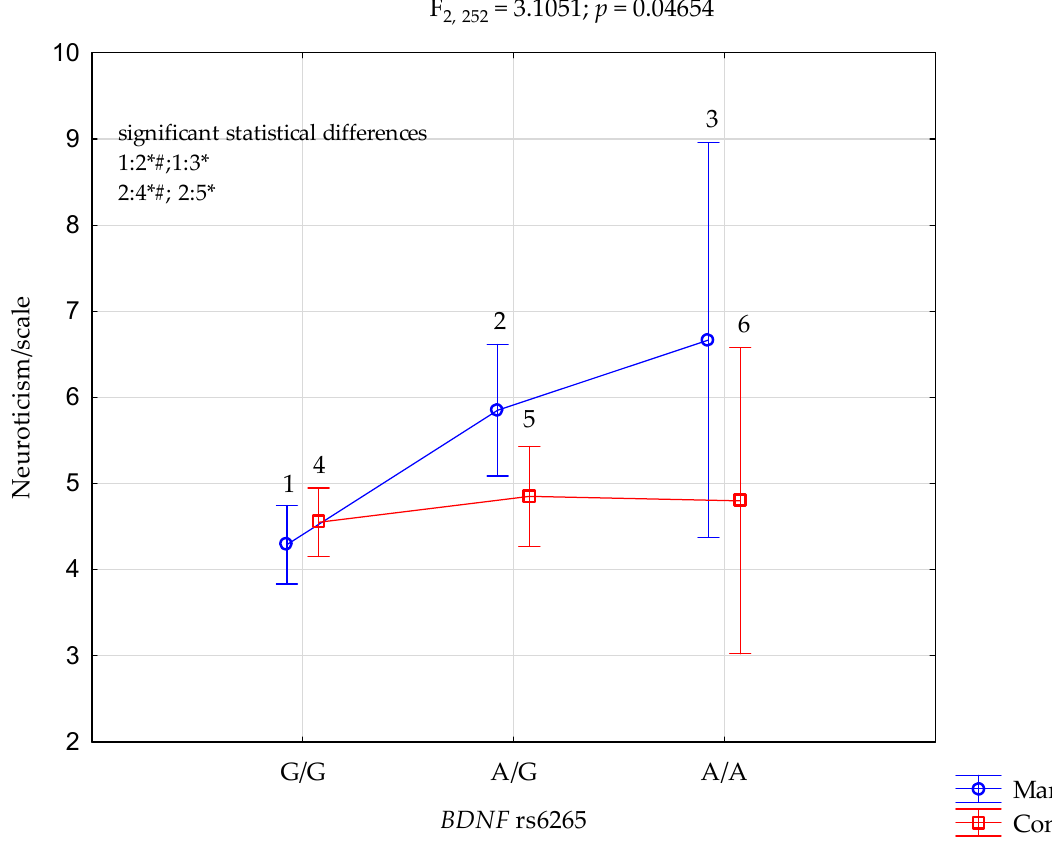
Figure 1. Interaction between martial arts/-Control and BDNF rs6265 and Neuroticism scale. # Bonferroni correction was used, and the p -value was reduced to 0.0083 ( p = 0.05/6 (number of statistical tests conducted)). G/G and A/A—genotypes (homozygotes), A/G—genotype (heterozygote), G and A—alleles, 1—G/G, 2—A/G, 3—A/A, 4—G/G, 5—A/G, 6—A/A., BDNF —Brain-Derived Table 3. The results of 2 × 3 factorial ANOVA for martial arts subjects and controls, NEO Five-Factor Inventory scale, and BDNF rs6265 .